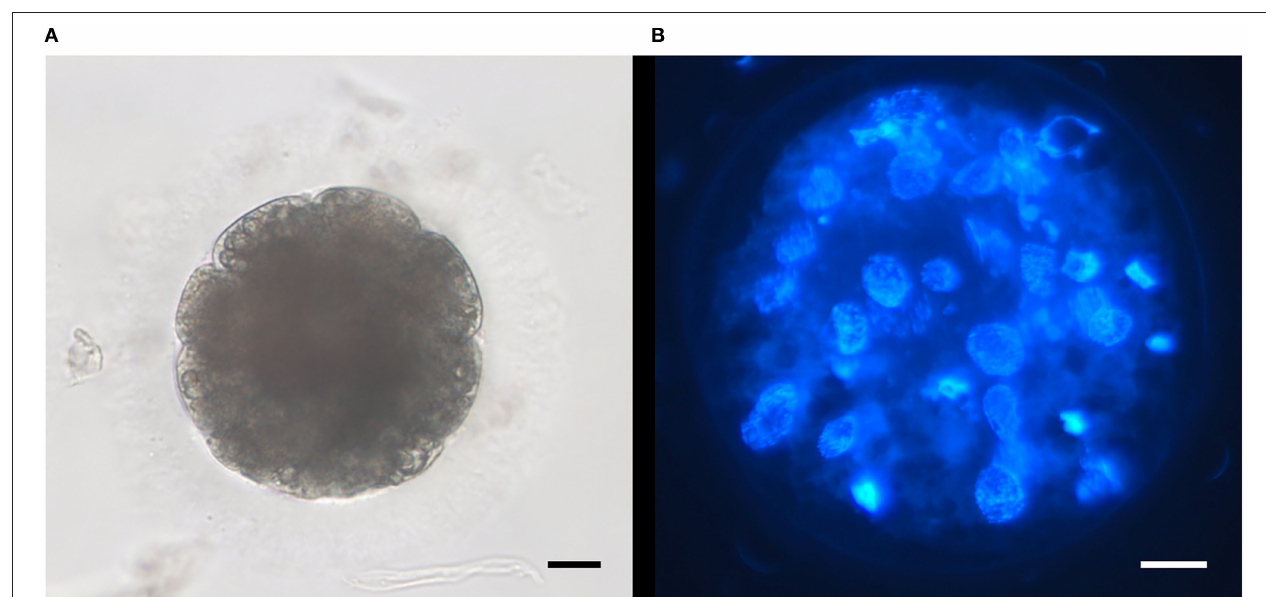
FIGURE 3 | Representative micrographs of embryos obtained after intracytoplasmic sperm injection (ICSI) of ultra-rapid frozen feline spermatozoa. (A) Embryo at day 5 of in vitro culture; objective 32X. (B) Morula after staining with Hoechst at the end of in vitro culture (day 7); objective 40X. Scale bars: 20 µ